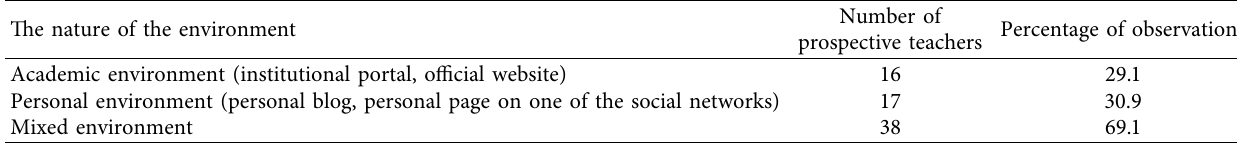
Table 7: The nature of digital environments handled by prospective teachers.